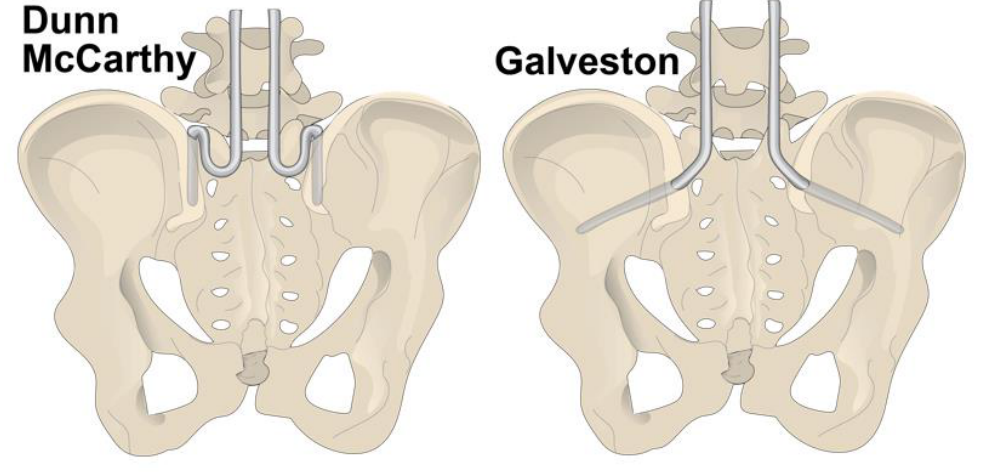
Figure 2. Galveston and Dunn-McCarthy methods for pelvic fixation of lumbar instrumentation.